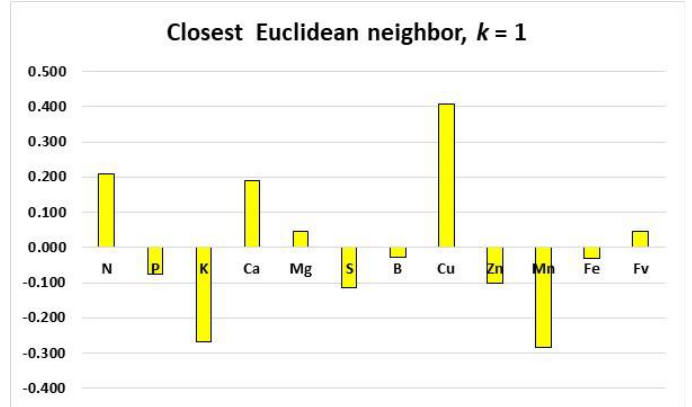
Figure 3. O rder of nutrient limitations in a defective ‘Valência’ X ‘Citrumelo Swingle’ specimen diagnosed at regional or blob ( k = 1 or 6) scales. The signs of clr indices indicate relative nutrient excess (+) or deficiency (-). Fruit yield averaged 53 – 67 tons ha −1 in the blobs compared to 20 tons ha −1 for the defective specimen.